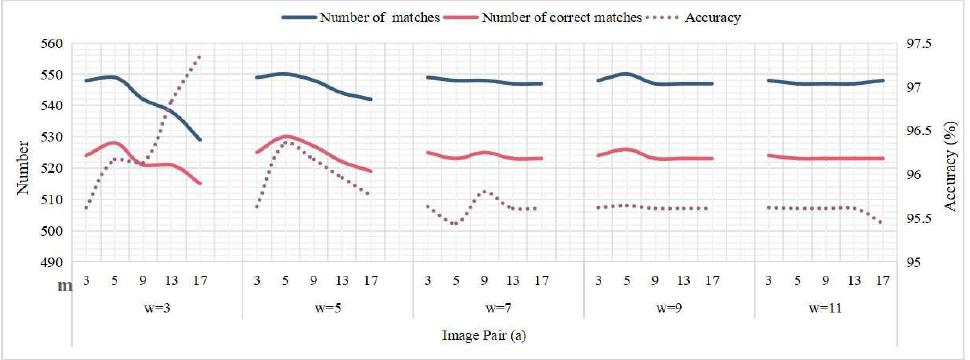
Figure 9. Performance of our approach with different m and w for Figure 7a image pair.